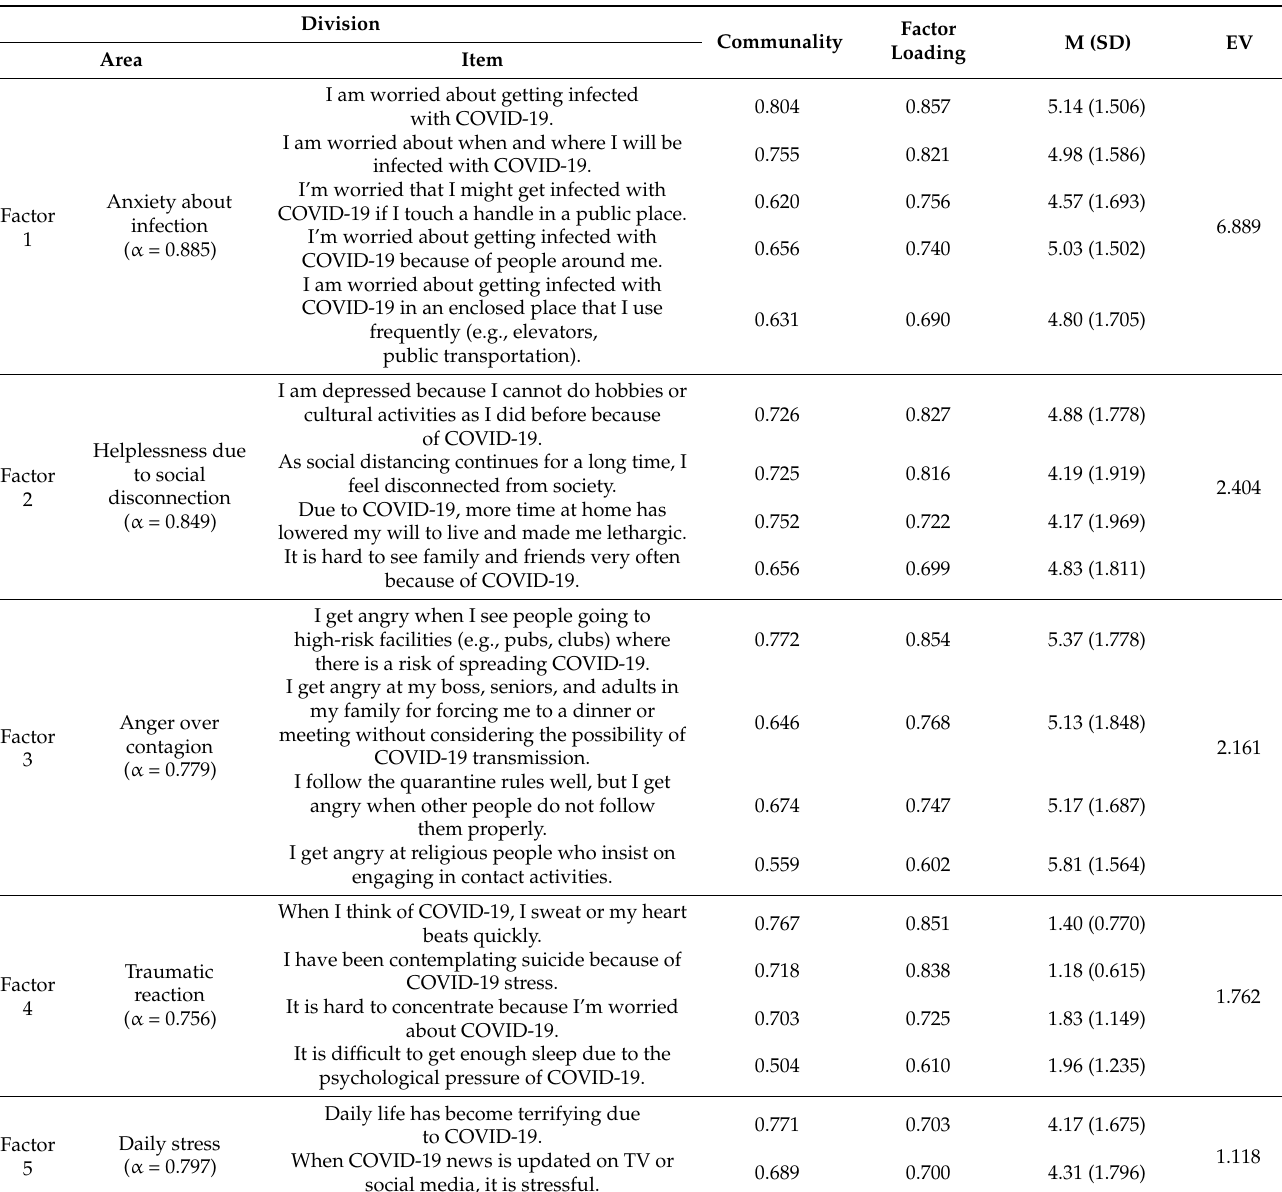
Table 5. Principal component analysis of COVID-19